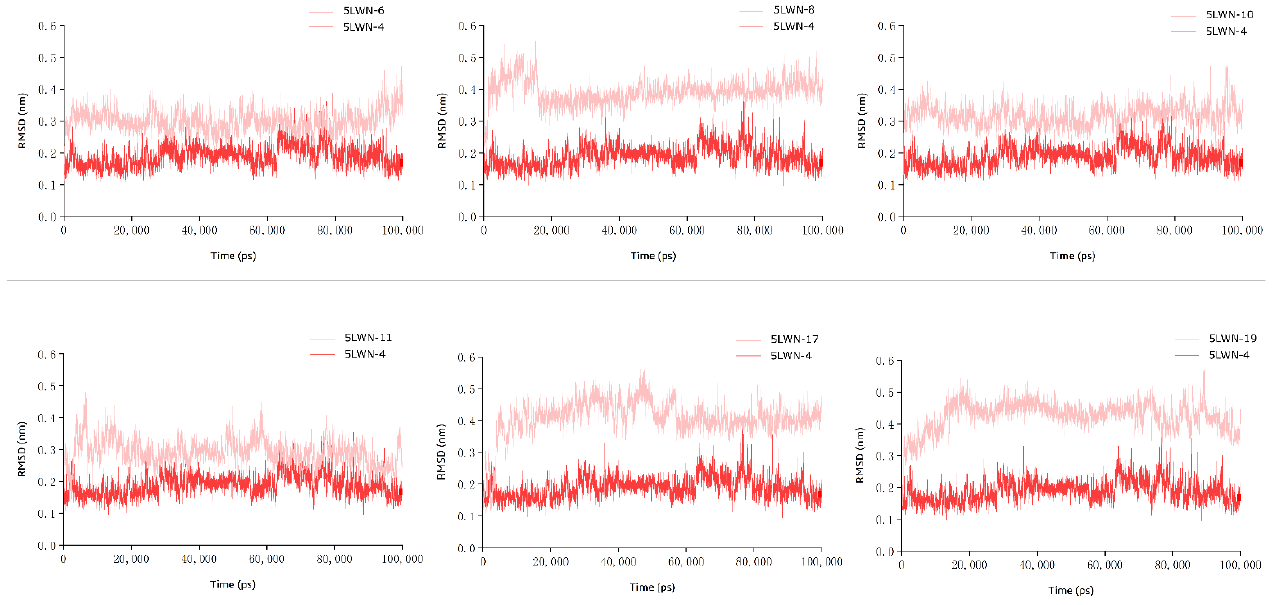
Figure 6. Comparison of RMSD of six inhibitors with eutectic ligands (79R) during molecular dynamics simulations.